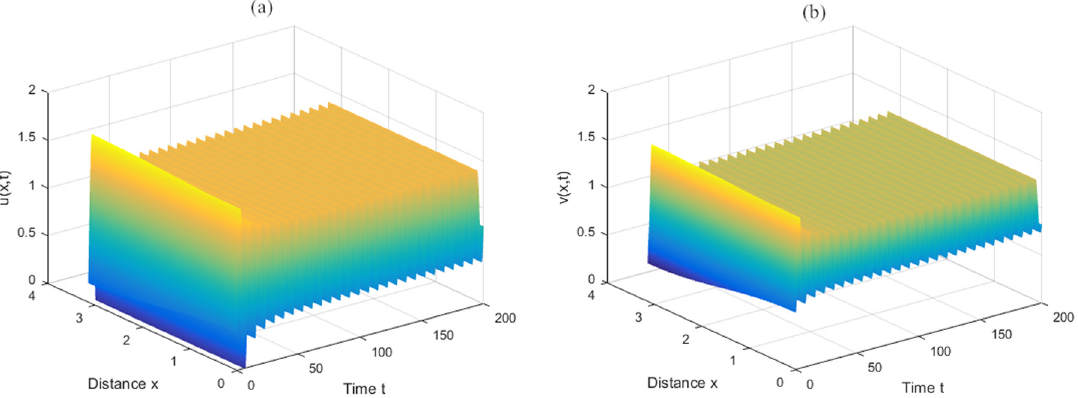
Figure 3: The positive equilibrium E ∗ of system ( 4.43 ) is unstable in the u x t − − space and v x t − − space,